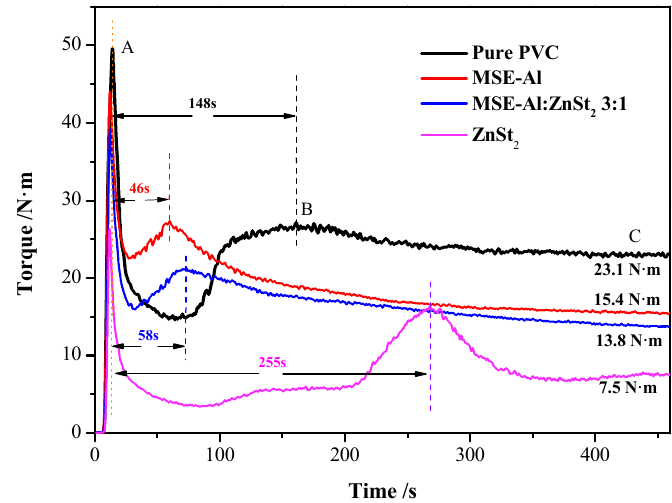
Figure 9. Results of time dependent torque rheology test obtained at 180 °C and 50 rpm rotation rate for pure PVC and PVC stabilized by 4 phr of different thermal stabilizers.